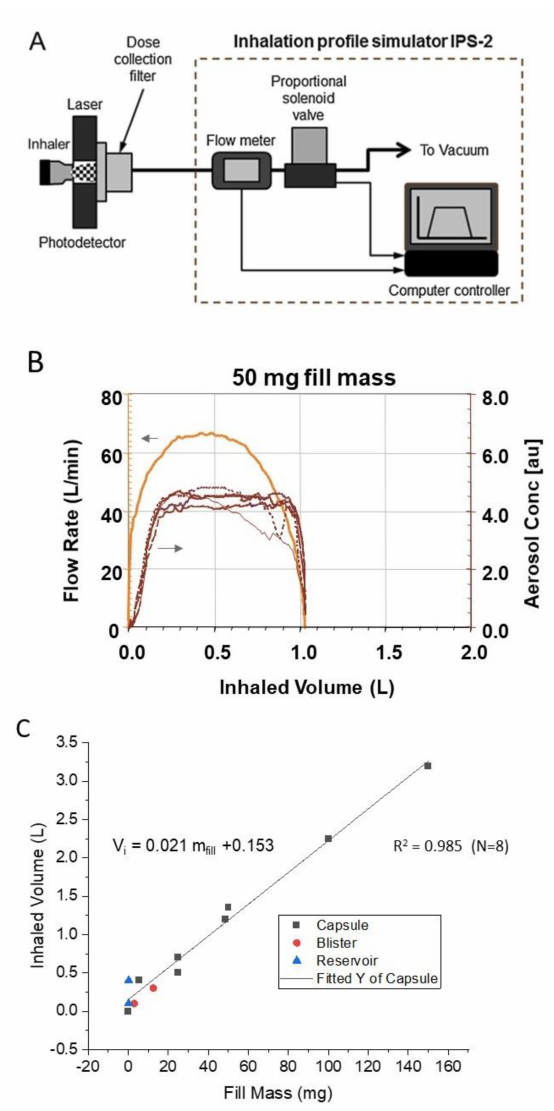
Figure 6. ( A ) Diagram of laser photometer system utilized to determine inhaled volume required to empty powder from a DPI [127,128]. The diagram was reproduced from [127] with permission from Elsevier, 2016; ( B ) Plot of a representative inspiratory flow profile and corresponding powder emptying profile for TOBI Podhaler using the laser photometer system; ( C ) Plot of the inhaled volume required to empty a fill mass for various inhaled products. DPIs included in the plot are: Asmanex ® Twisthaler ® , Pulmicort ® Flexhaler ® , Spiriva HandiHaler, Advair ® Diskus ® , Onbrez Breezhaler, indacaterol Simoon™, vardenafil AOS ® , Cipro T-326, TOBI Podhaler, CSJ117 T-326 [93,127,128]. It should be noted that the curve is dominated by capsule DPIs except at low fill